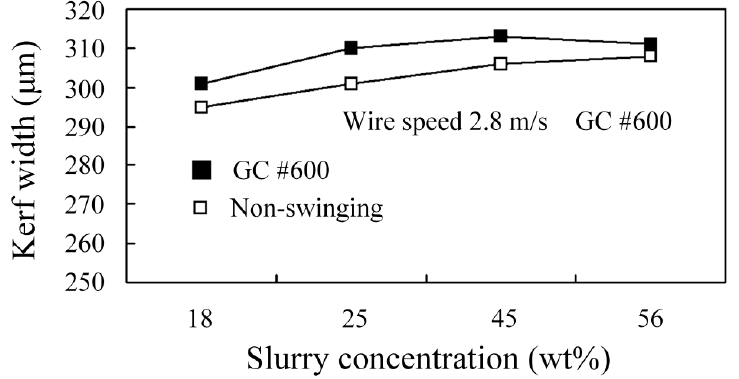
Figure 16. Effect of wire speed on kerf width for different slurry concentrations.